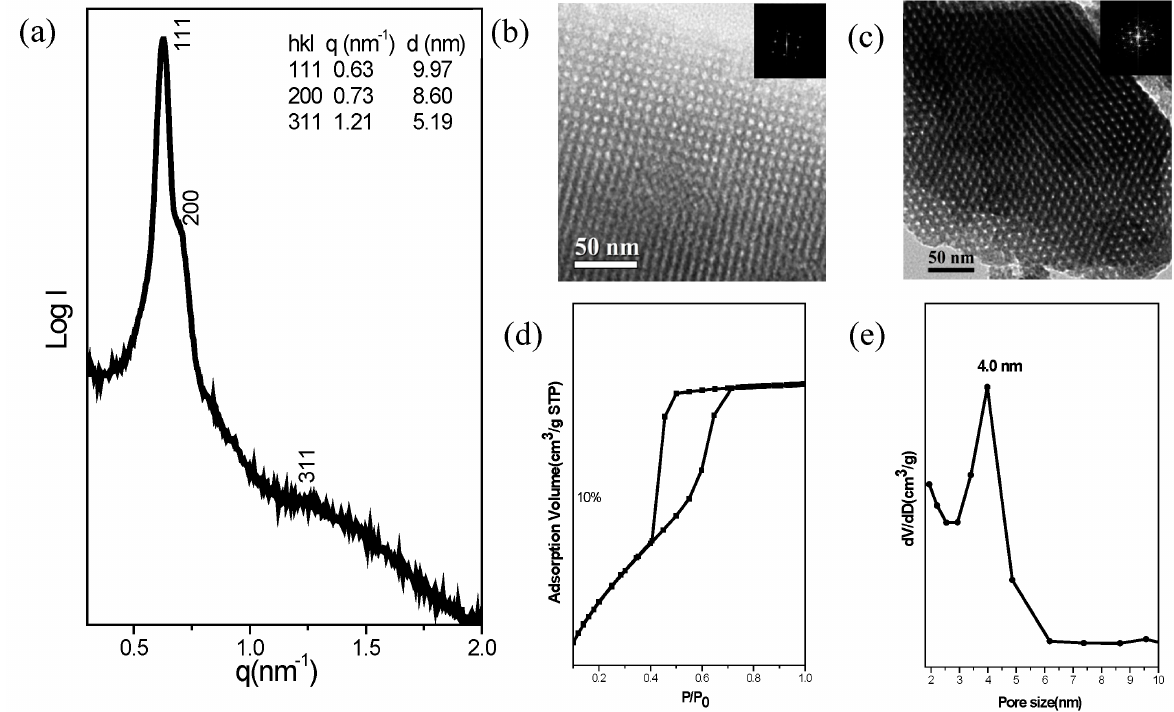
Figure 5. ( a ) SAXS; ( b ) TEM image viewed from (100); ( c ) TEM image viewed from (110) (insets: corresponding FFT); ( d ) N 2 adsorption/desorption isotherm; and ( e ) Pore size distribution curve of the fcc mesoporous silica templated by F127 at a TEOS/OV-POSS-SILY (10 wt.%)-to-F127 ratio of